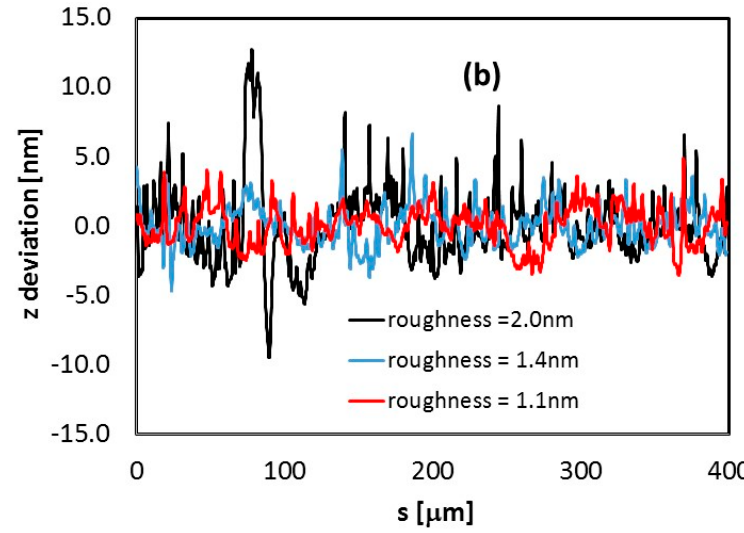
Figure 4. ( a ) Thickness profile (z direction) measured along a 900 µm path from the center of the In 2 O 3 sample deposited on glass. ( b ) Thickness deviation from flat-film condition, estimated along three different profiles, 400 µm-long, within the same In 2 O 3 230 nm-thick film deposited on a glass substrate. For each of them, roughness is calculated as the average value of absolute deviation data.